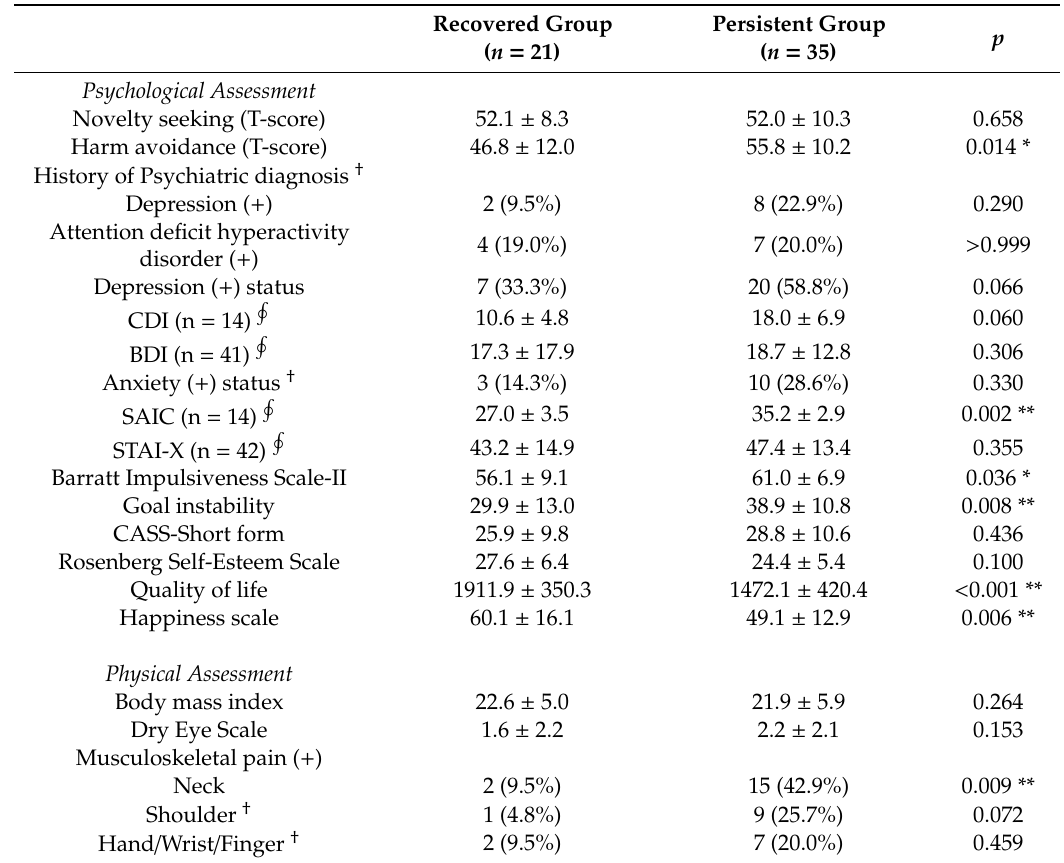
Table 2. Baseline comparison of psychological and physical measures between recovered and persistent